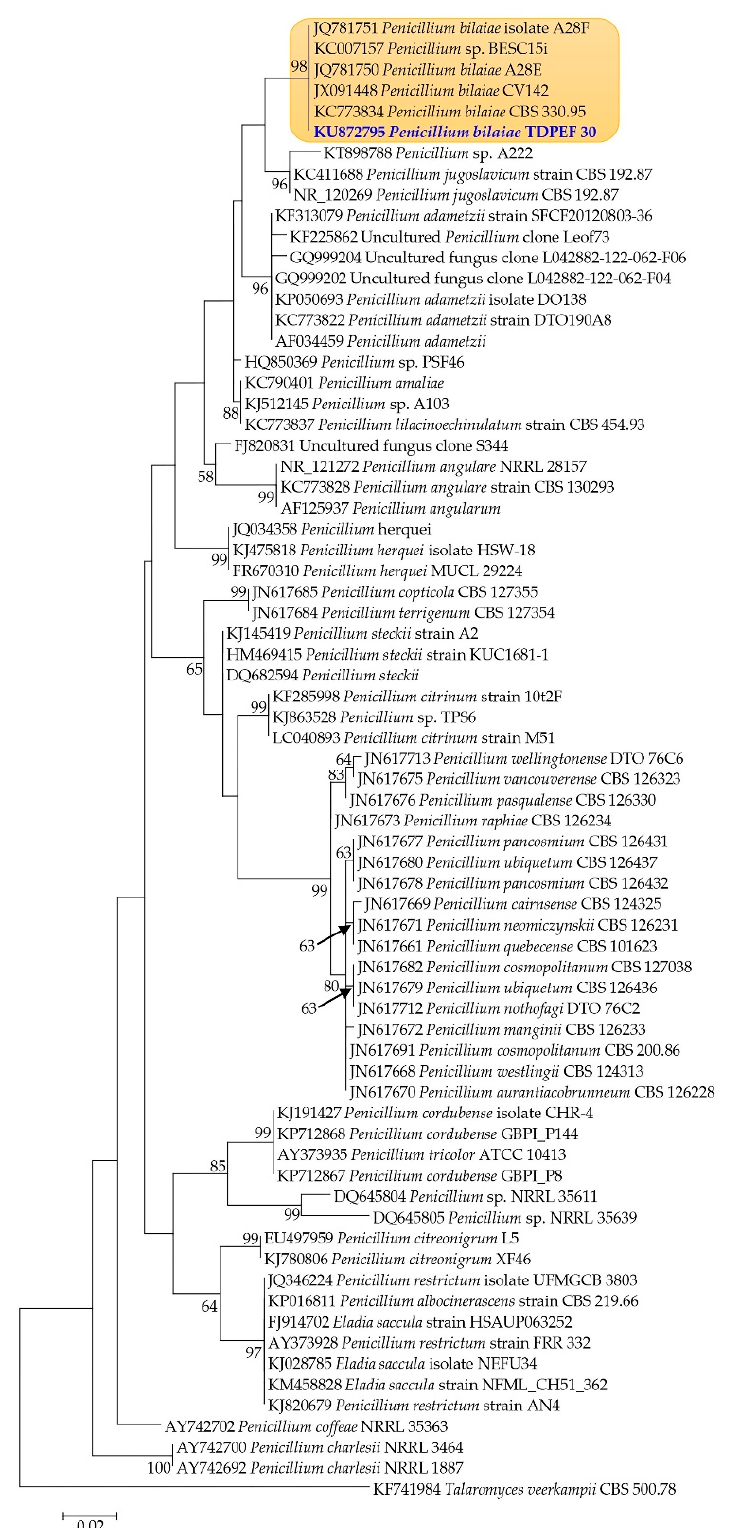
Figure 1. Phylogenetic tree based on 18S rRNA sequence highlighting the phylogenetic position of Penicillium bilaiae TDPEF30 within closely related Penicillium spp. Talaromyces veerkampii (CBS 500.78, KF741984) was used as an outgroup. Bootstrap values are expressed as percentage of 1000 replicates.